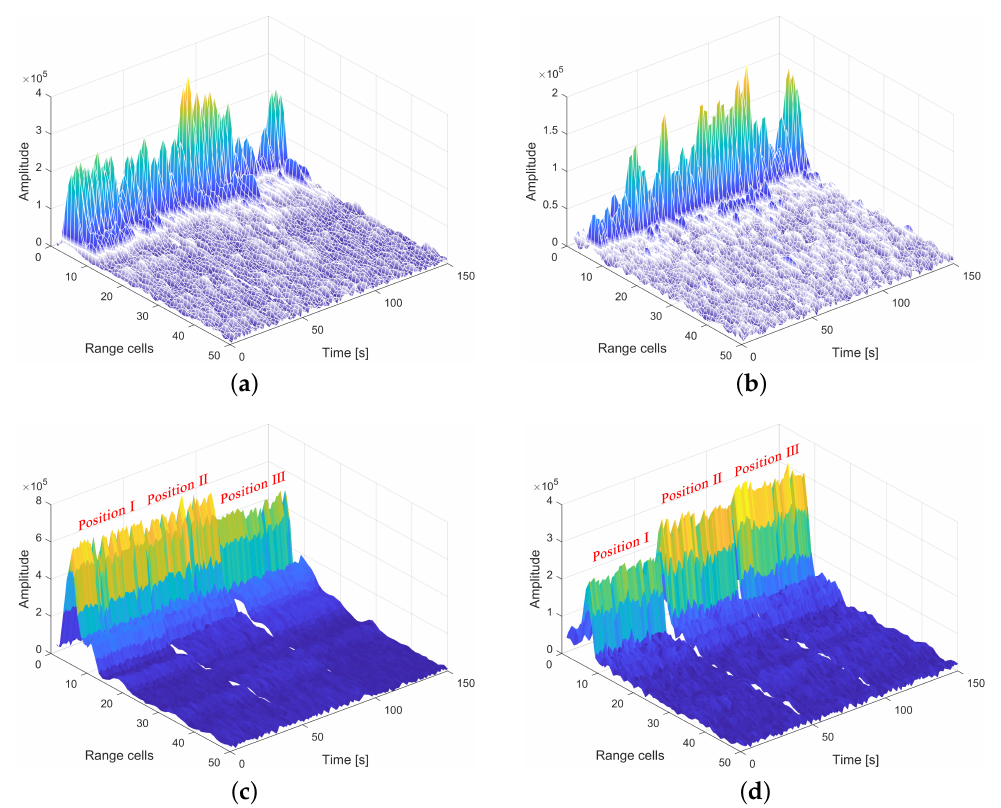
Figure 8. Coherent accumulation results of three positions. ( a ) C01 observation with NDM ( b ) C04 observation with NDM ( c ) C01 observation without NDM ( d ) C04 observation without